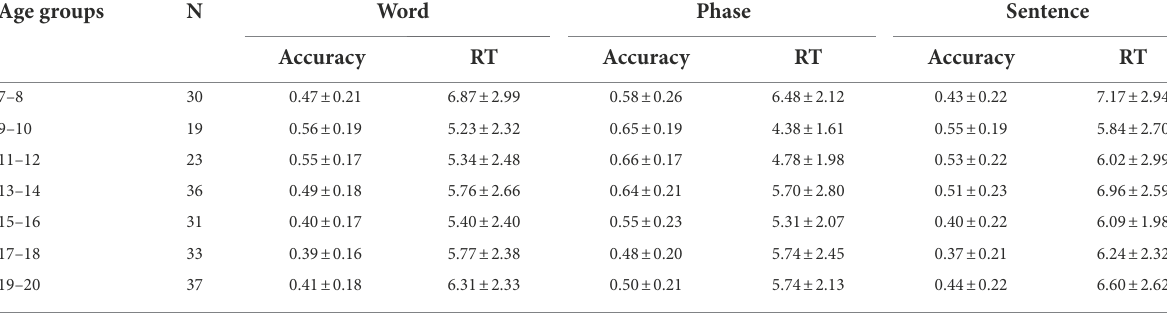
TABLE 2 Accuracy rate (% correct) and mean response time (RT in seconds) according to age group and linguistic level. Age